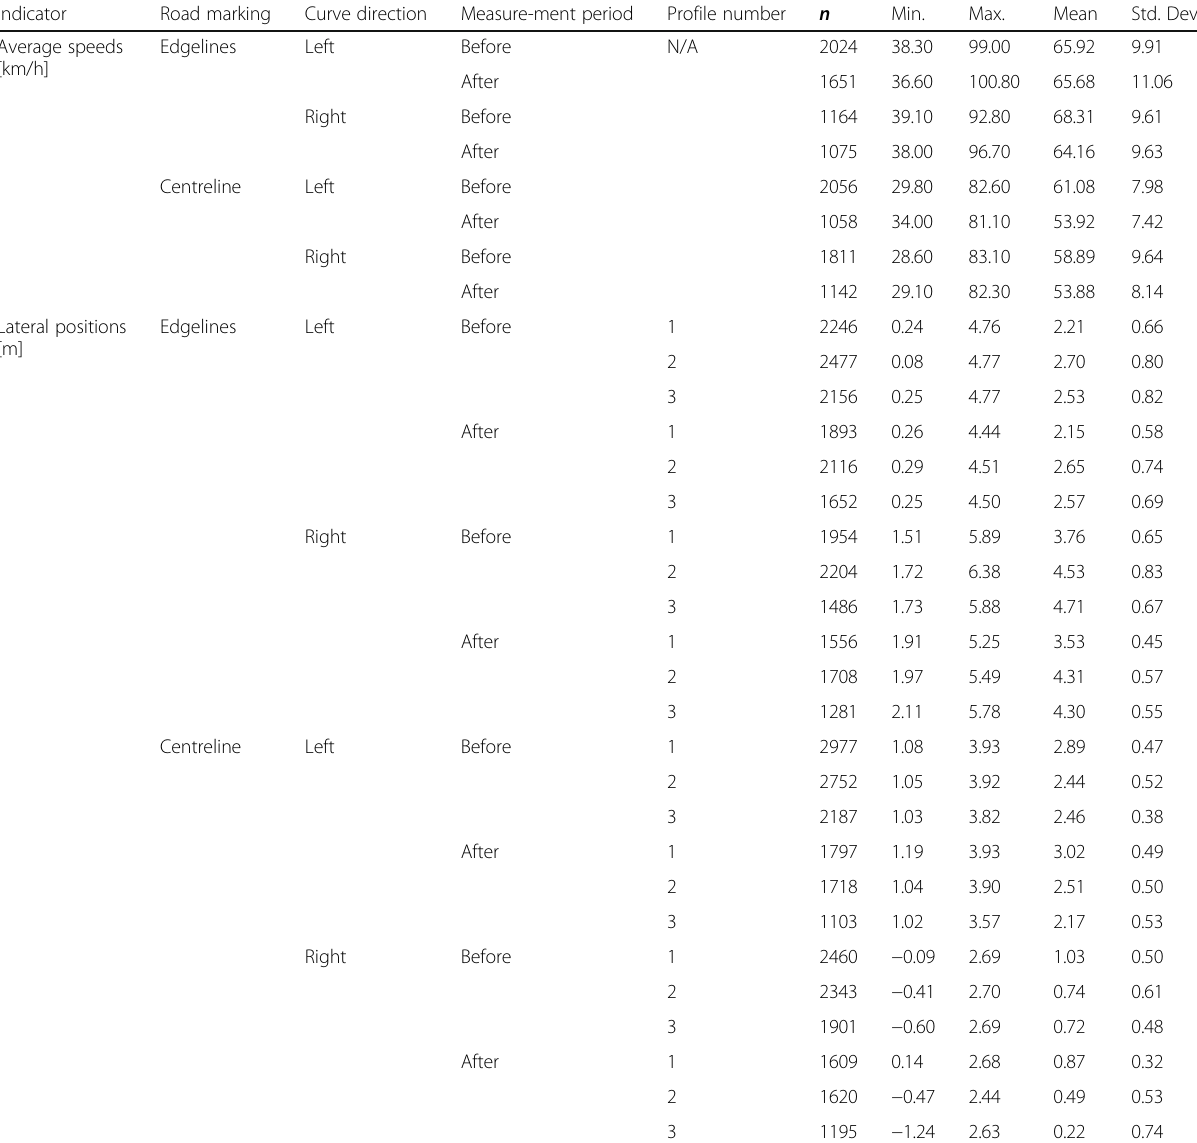
Table 3 Sample sizes (n) and descriptive characteristics of average speed and lateral position data Indicator Road marking Curve direction Measure-ment period